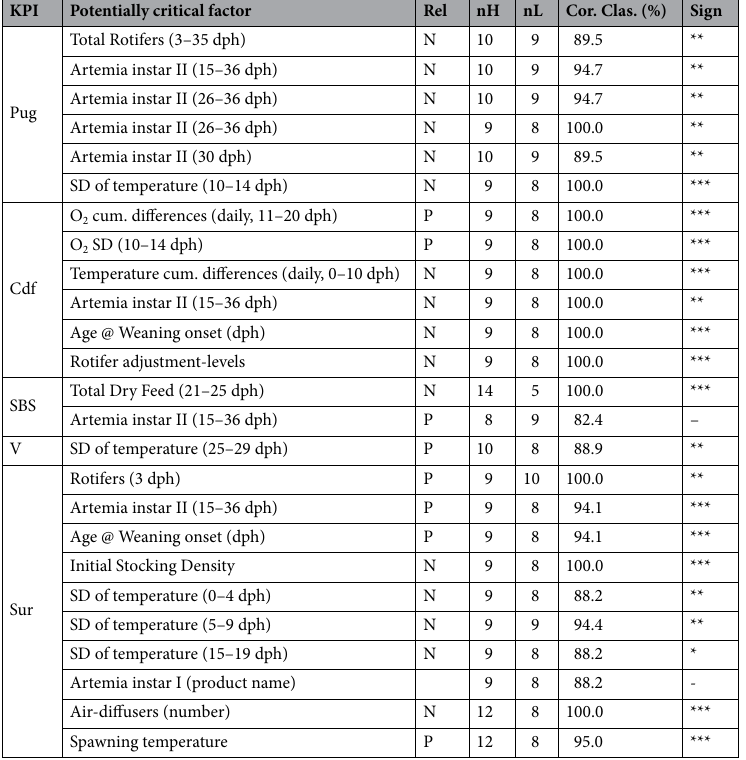
Table 3. Critical factors for certain KPIs in the different hatcheries, as indicated by classification tree models. “Rel” column indicates the type of relationship between KPIs and critical factors (P, positive; N, negative), “nH” and “nL” columns the count of cases with high and low quality respectively, “Cor. Clas.” the % of correct classifications, and “Sign.” the significance of the difference in the critical factors between the nH and nL V, vertebral abnormalities. KPI to critical factor association is purely statistically based on the specific data provided. They can serve only in building hypotheses to be tested by each hatchery.